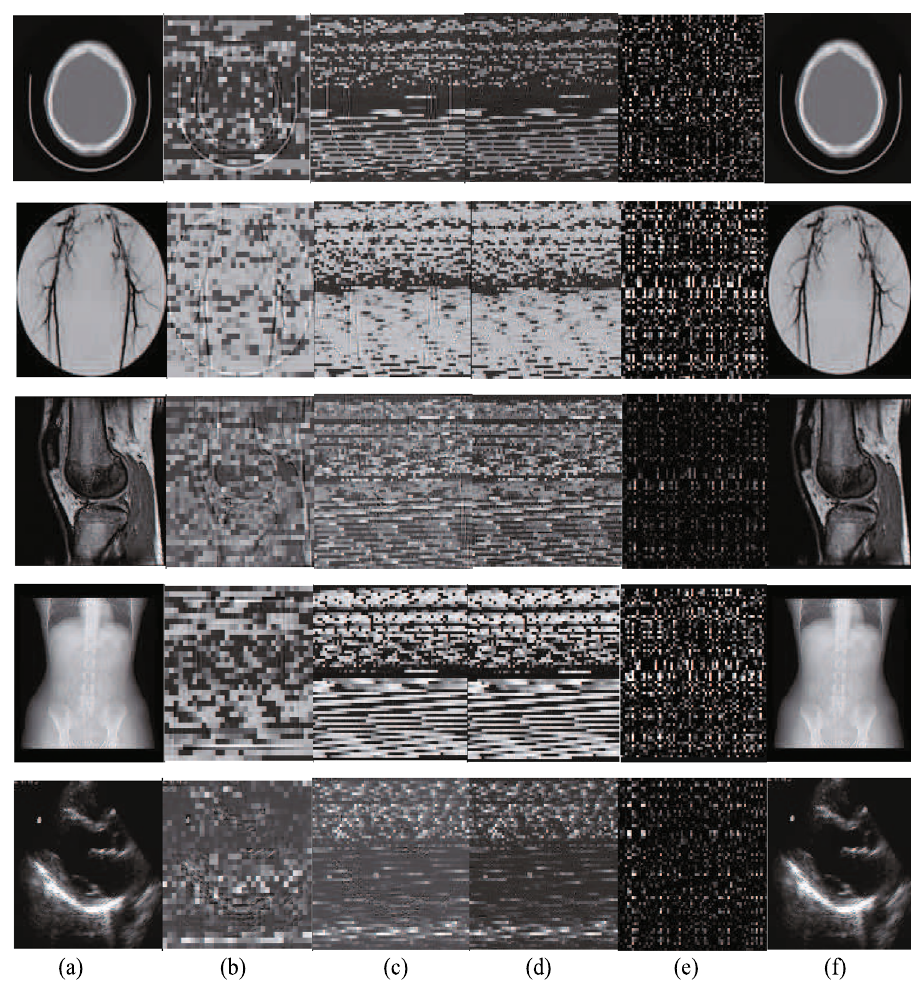
Fig. 6 Discussion of the selective encryption: ( a ) original medical images, ( b ) 4 × 4 blocks permutation via GOL in the LL2 subband, ( c ) images which are permutated by single coefficient permutation via GOL, ( d ) images which are permutated by 4 × 4 blocks permutation in the LL2 subband, HL subbands, and LH subbands, ( e ) 4 × 4 blocks permutation in